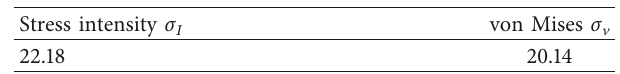
Table 10: The maximum combined stress (MPa).